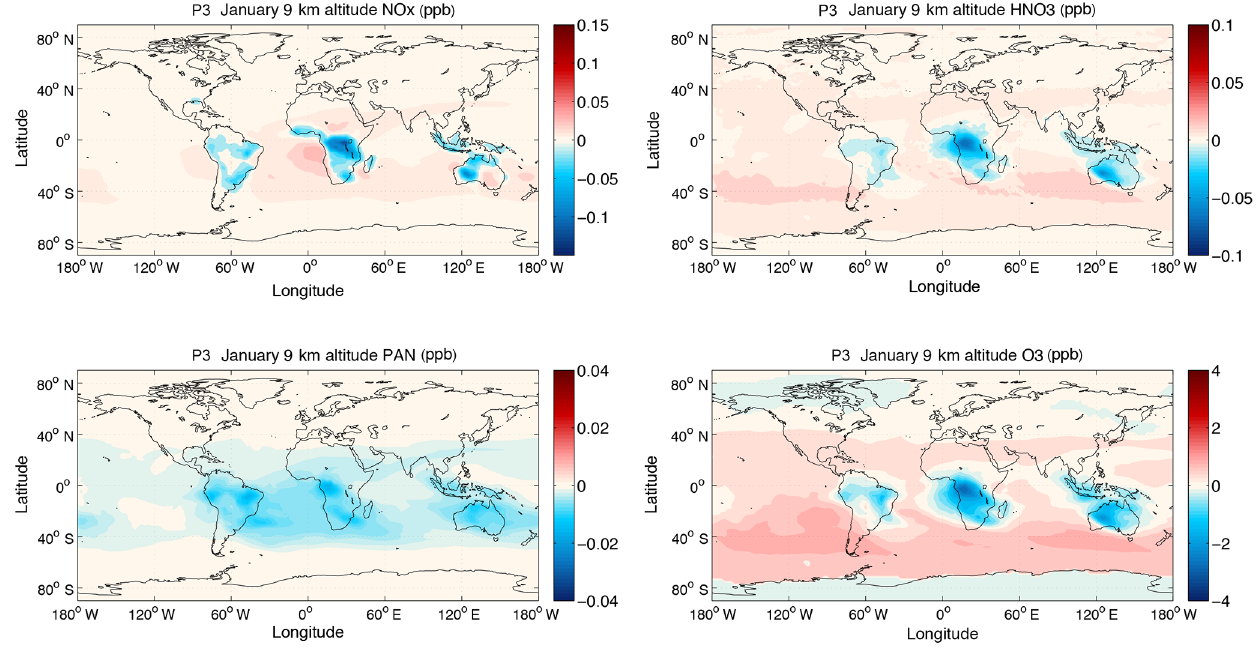
Figure 4. Geographical distributions of NO x , HNO 3 , PAN, and O 3 variations (in ppb) at 9km altitude for January from the absolute difference (P3) between P1 and BC experiments. P1 was performed using τ and K eff determined with D h = 15m 2 s − 1 and NO mean GEOS-Chem.